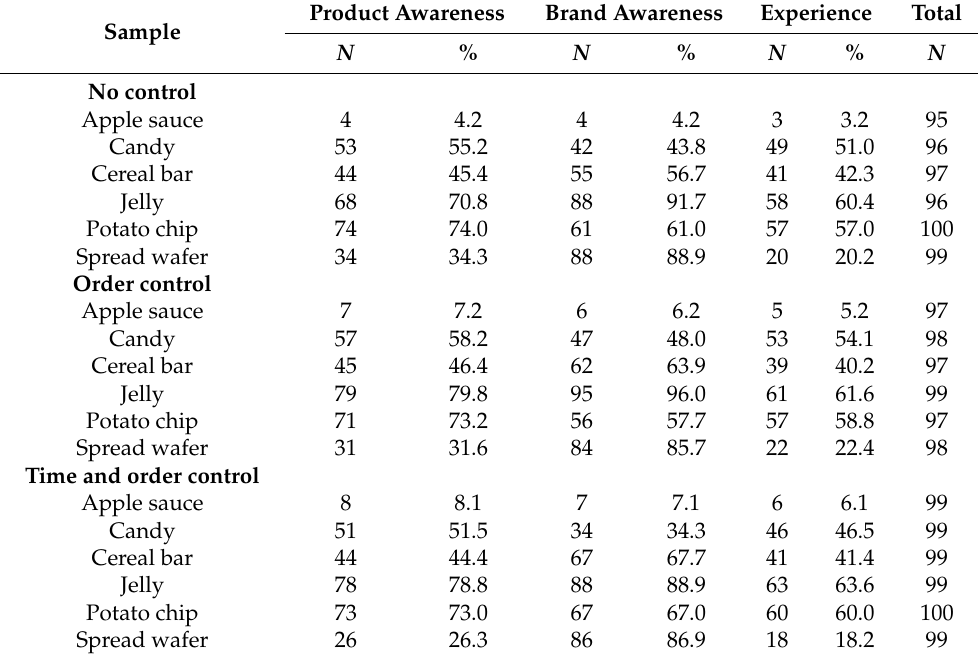
Table 7. Knowledge of samples 1 .